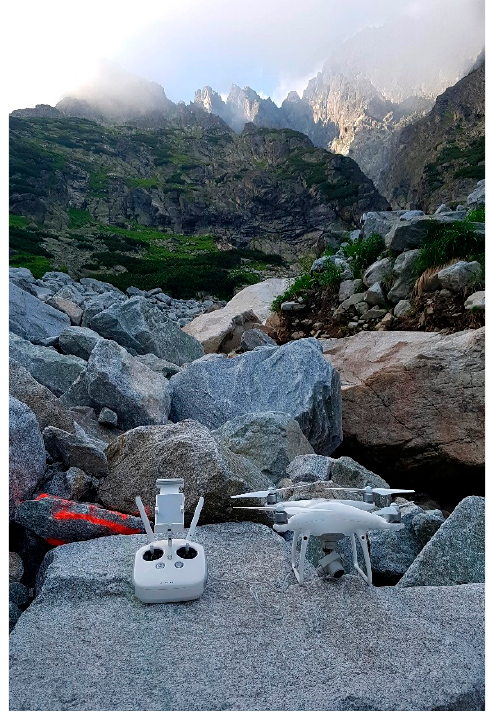
Table 3. UAS DJI Phantom 4 Pro characteristics. Aircraft Weight (with Battery and Propellers):